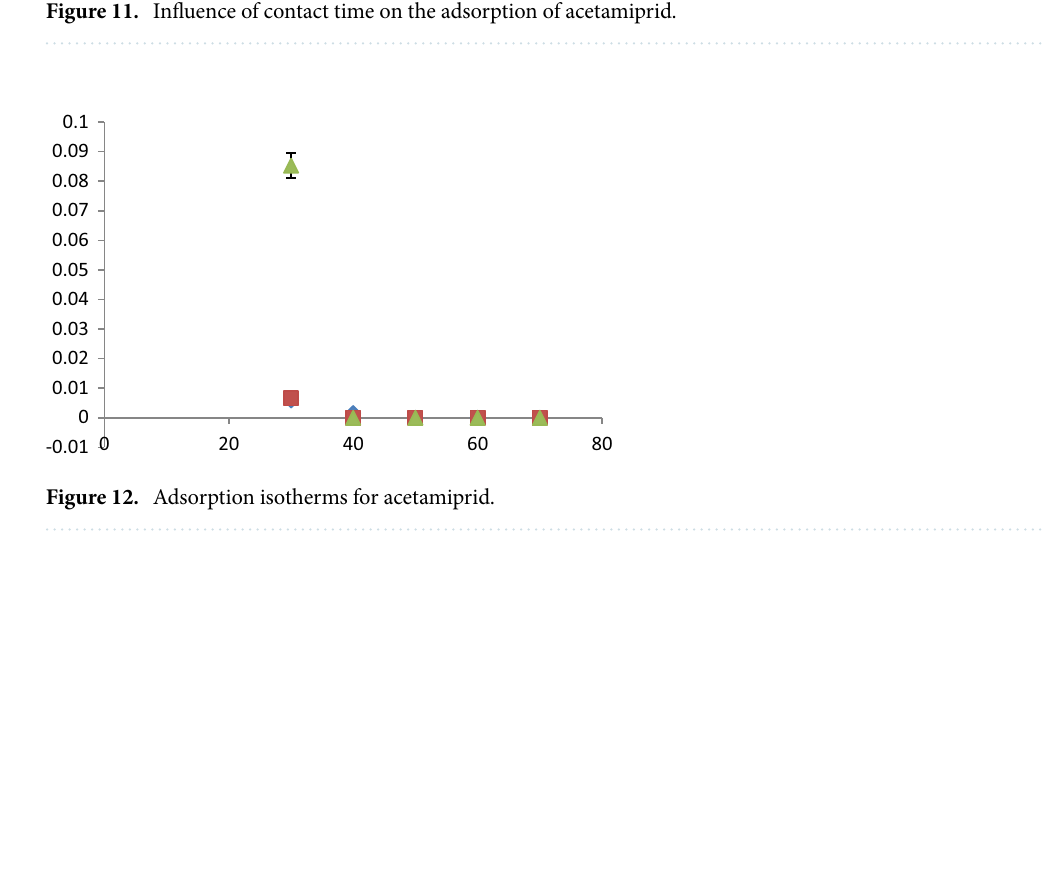
Figure 11. Influence of contact time on the adsorption of acetamiprid.